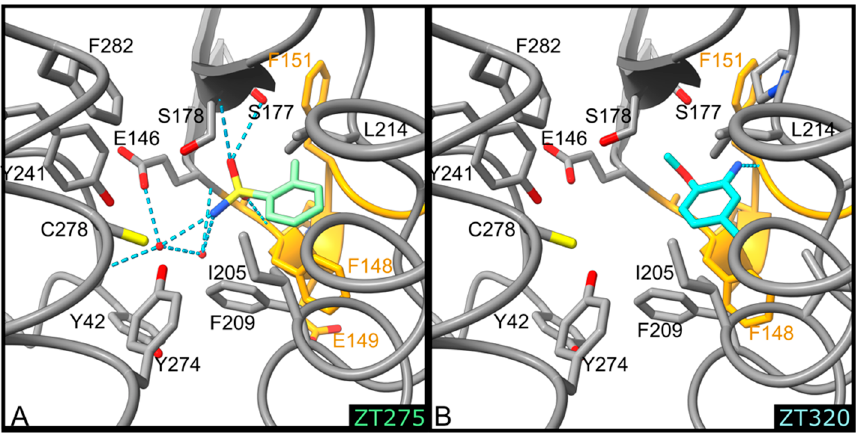
Figure 5. Detailed representation of binding of ZT275 ( A , pale green) and ZT320 ( B , turquoise) at the substrate binding site. The protein is represented as a ribbon, the side chains of residues involved in ligand biding are shown as sticks and labelled, water molecules as red spheres, and hydrogen bonds as blue dotted lines. Residues 148–151 forming helix η 1 are coloured orange.